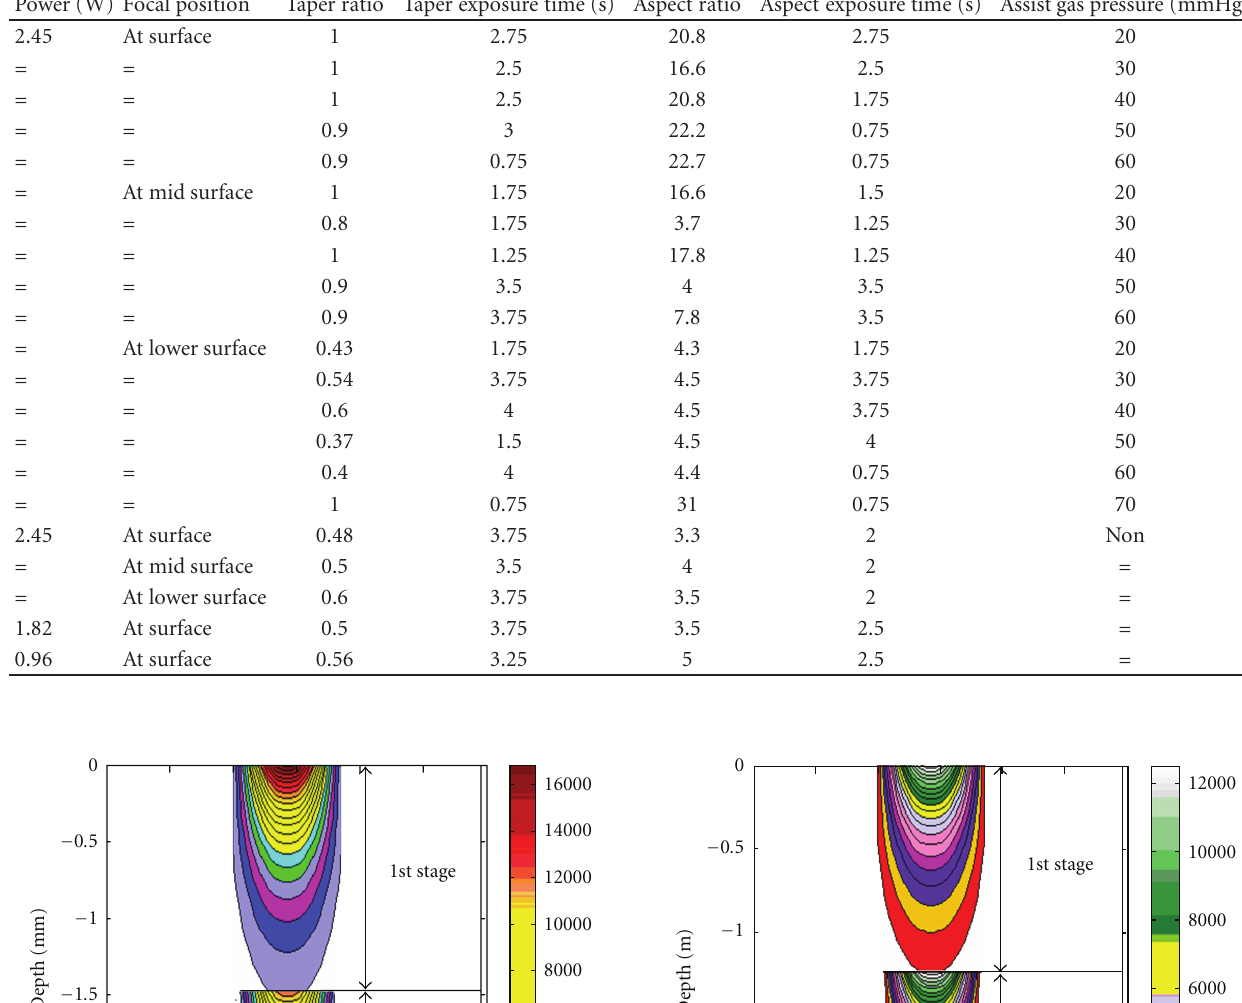
Table 2: The di ff erent experimental values of A r and T r at di ff erent working conditions. Power (W) Focal position